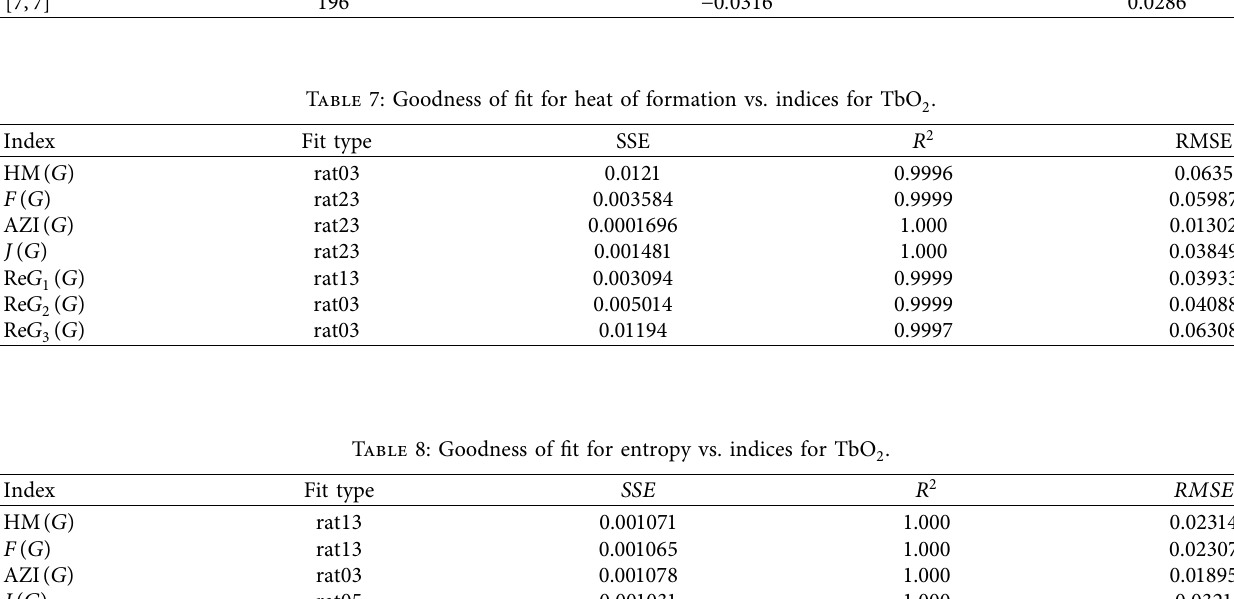
Table 7: Goodness of fit for heat of formation vs. indices for TbO